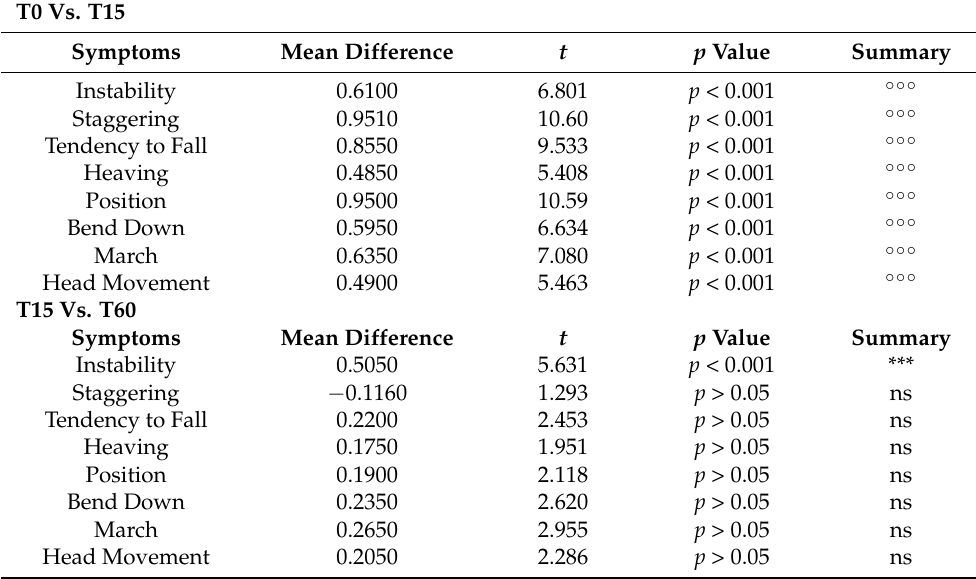
Table 2. Statistical analysis obtained using a Bonferroni post-hoc test on the factors triggering the